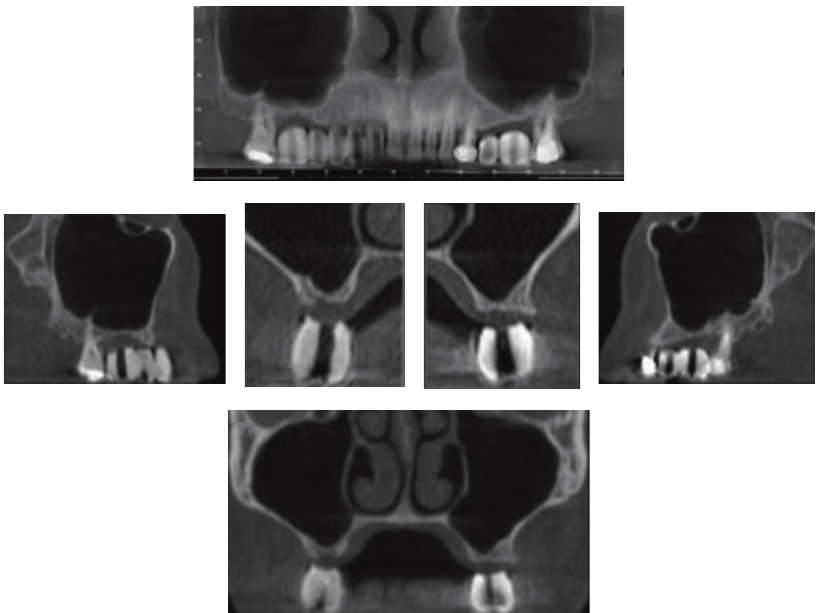
Figure 1: Baseline. The CBCT images show the posterior upper jawbone